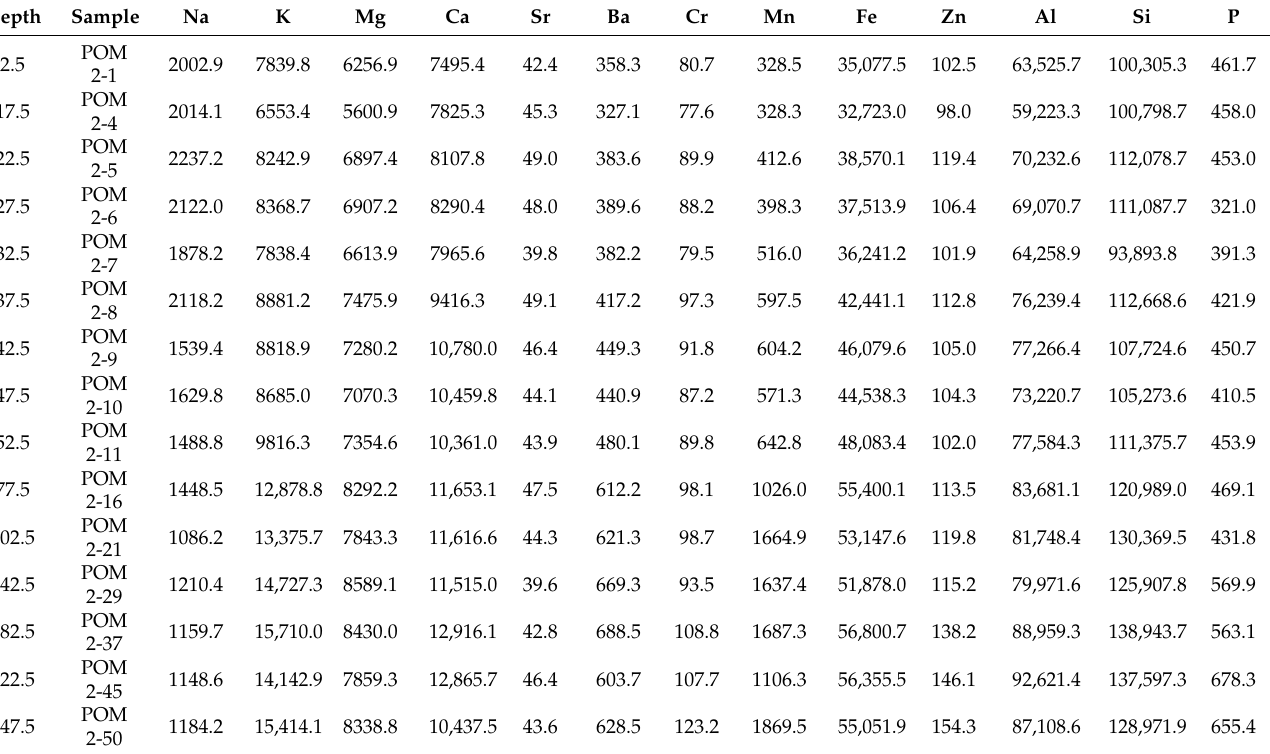
Table 1. Element concentration values of selected metals expressed in